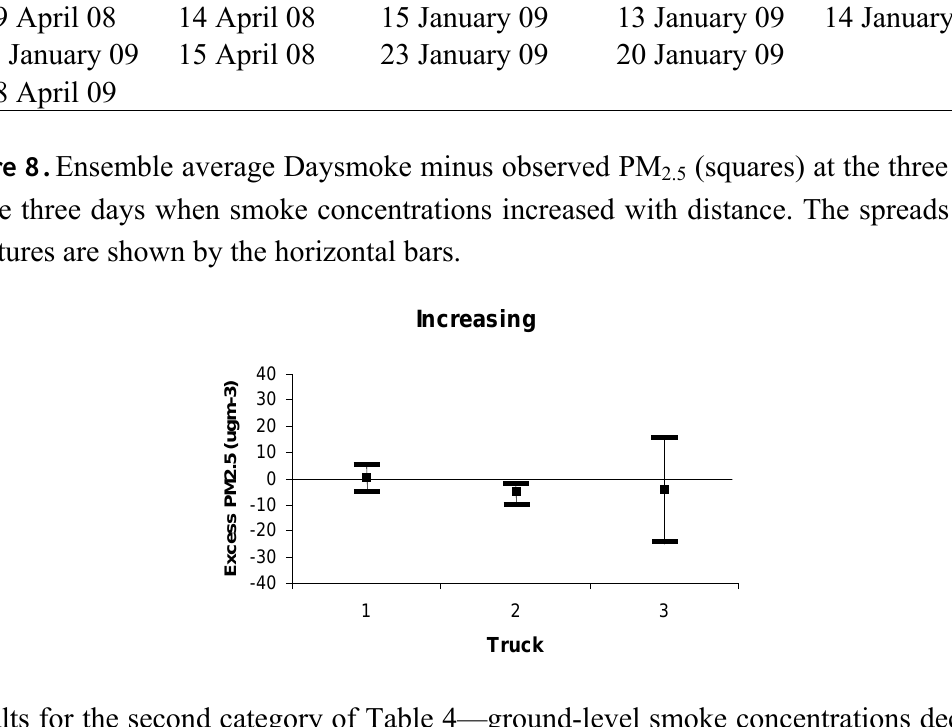
(squares) at the three trucks 2.5